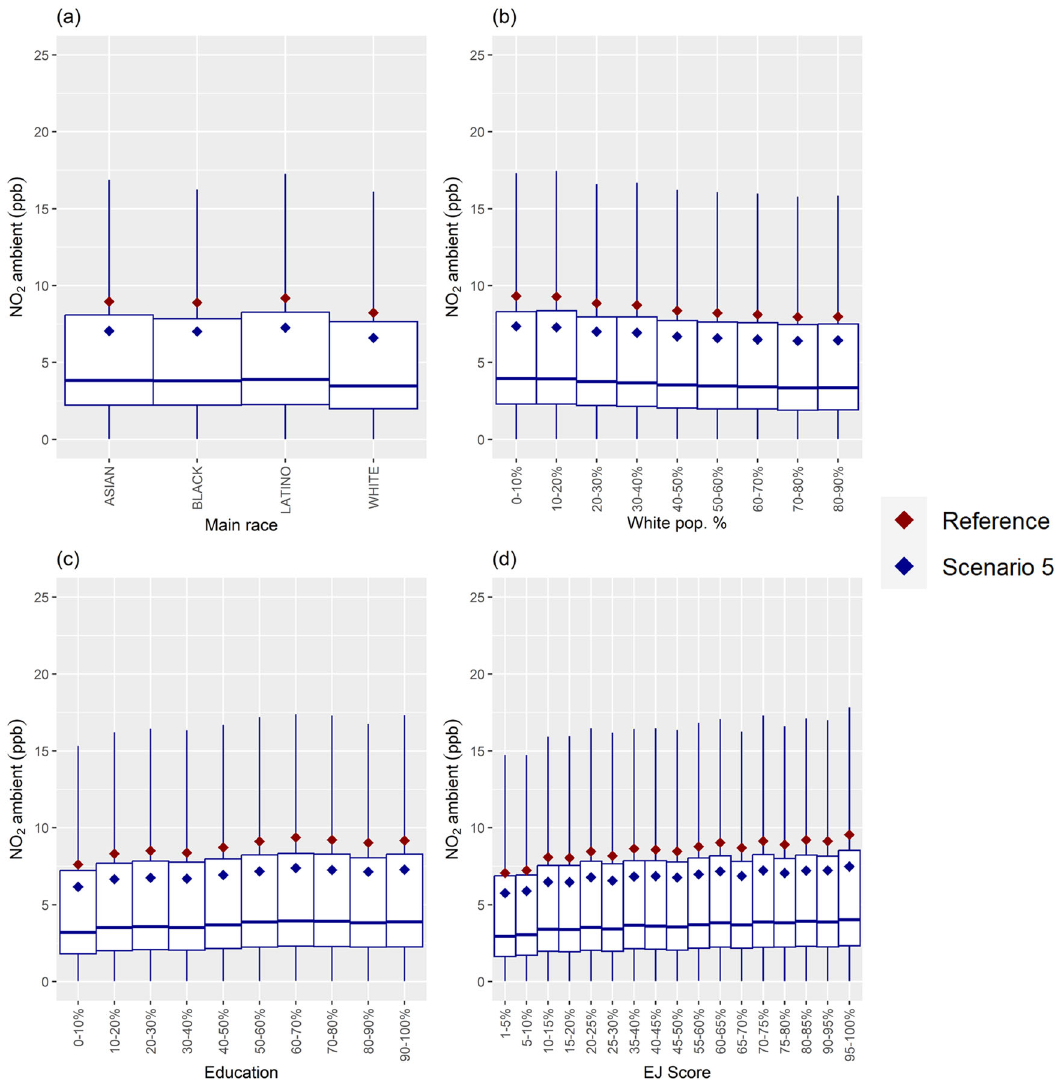
Fig. 6 NO 2 concentrations grouped by CalEnviroScreen EJ parameters for Scenario 5. The EJ parameters include ( a ) race, ( b ) white population percentage, ( c ) percent of population with a degree lower than high school, and ( d ) the fi nal score in CalEnviroScreen. Blue diamonds represent mean concentrations, and the horizontal lines represent the median. Boxes are bound by the scenario ’ s 25% and 75% ranges. Reference Case means shown as red diamonds for comparison. The whiskers extend to 1.5 times of the IQR from the